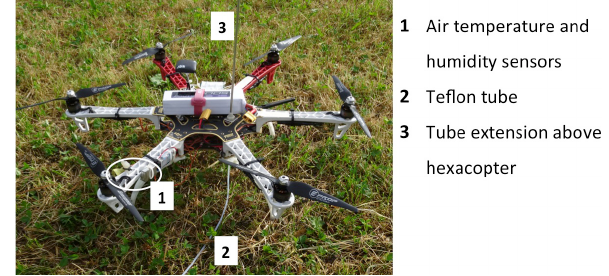
Figure 2. DJI F550 multicopter with installed sensors and